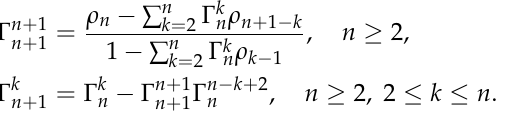
depending on H 5